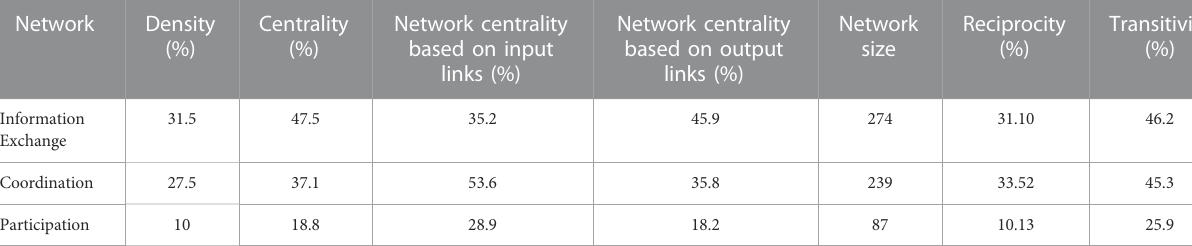
TABLE 4 Indicators measured of the studied networks.